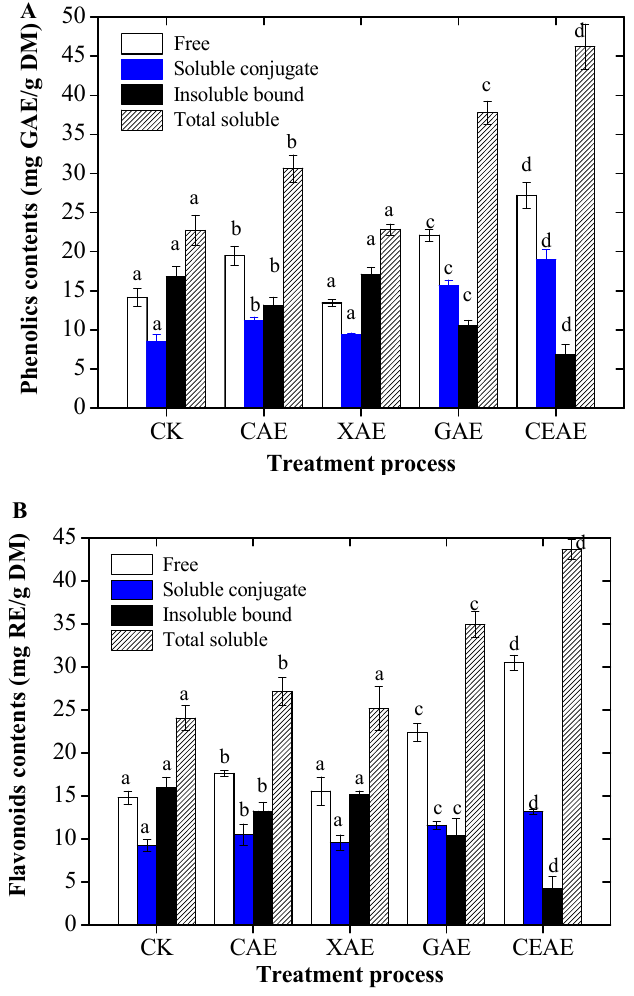
Figure 1. Contents of phenolics ( A ) and flavonoids ( B ), including free, soluble-conjugate, insoluble-bound, and total soluble extracts from guava leaves after different enzyme-assisted extraction. CK, untreated; CAE, cellulase-assisted extraction; XAE, xylanase-assisted extraction; GAE, β -glucosidase-assisted extraction; CEAE, complex enzyme-assisted extraction. Values with different letters in each column are significantly different following enzyme-assisted extraction. All experiments were repeated three times and data are expressed as the mean ± standard deviation (SD).